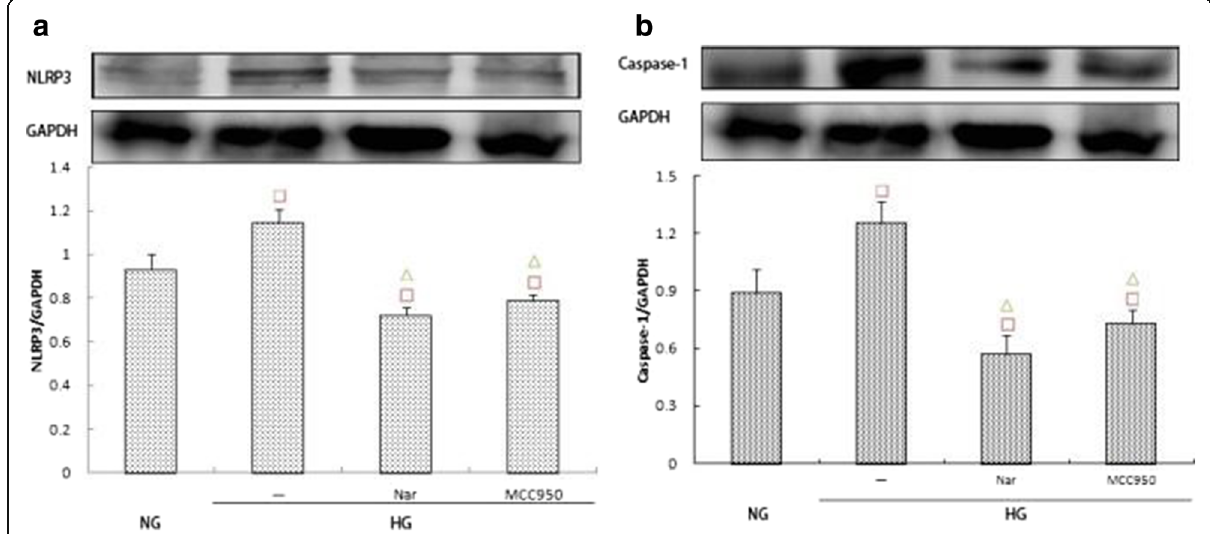
Fig. 10 a , b Effects of naringin (40umol/L) and MCC-950 (100umol/L) on the expression of NLRP3 and Caspase-1 within the high glucose group. The protein was measured by western blotting.GAPDH was used as an internal loading control. NG:normal control group,HG:high glucose group,Nar:naringin 40umol/L+ HG,MCC950:MCC-950 100umol/L + HG.Data are presented in mean ± SD, □ P < 0. 05 versus normal control group, △ P < 0. 05 versus high glucose